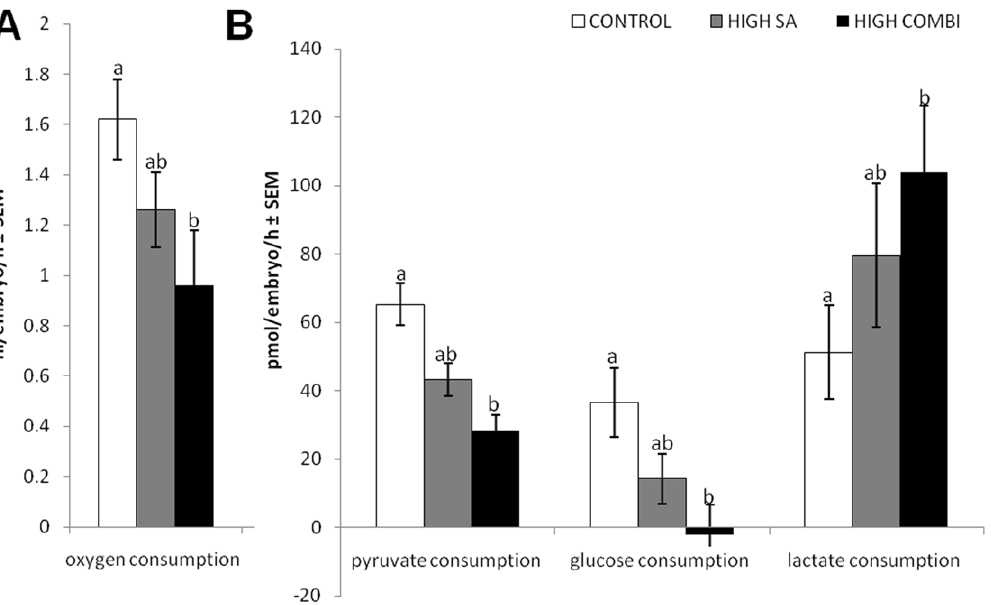
Figure 3. Key processes of ATP production are significantly altered in blastocysts arising from oocytes exposed to NEFA. A. Mean oxygen consumption of day 7 blastocysts. Blastocysts (n=66; three replicates) were derived from control-, HIGH SA- and HIGH COMBI-exposed oocytes. Different superscripts indicate significant differences between treatments (P , 0.05). B. Mean pyruvate, glucose and lactate consumption of blastocysts. Blastocysts (n=84; five replicates) originated from oocytes matured in control, HIGH SA and HIGH COMBI maturation medium. Different superscripts indicate significant differences between treatments (P , 0.05).